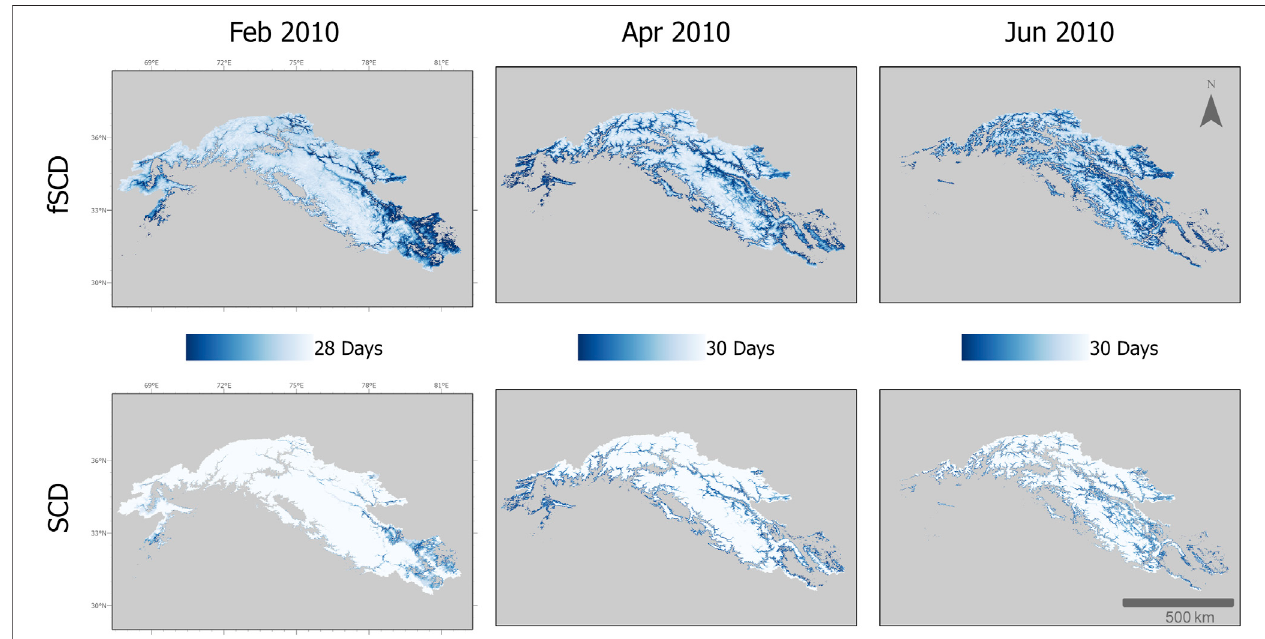
FIGURE 6 | A sample of SCD and fSCD maps across the Indus basin that demonstrates the variation between the two metrics during the snowmelt season, speci fi cally during the months of February, April, and June 2010.